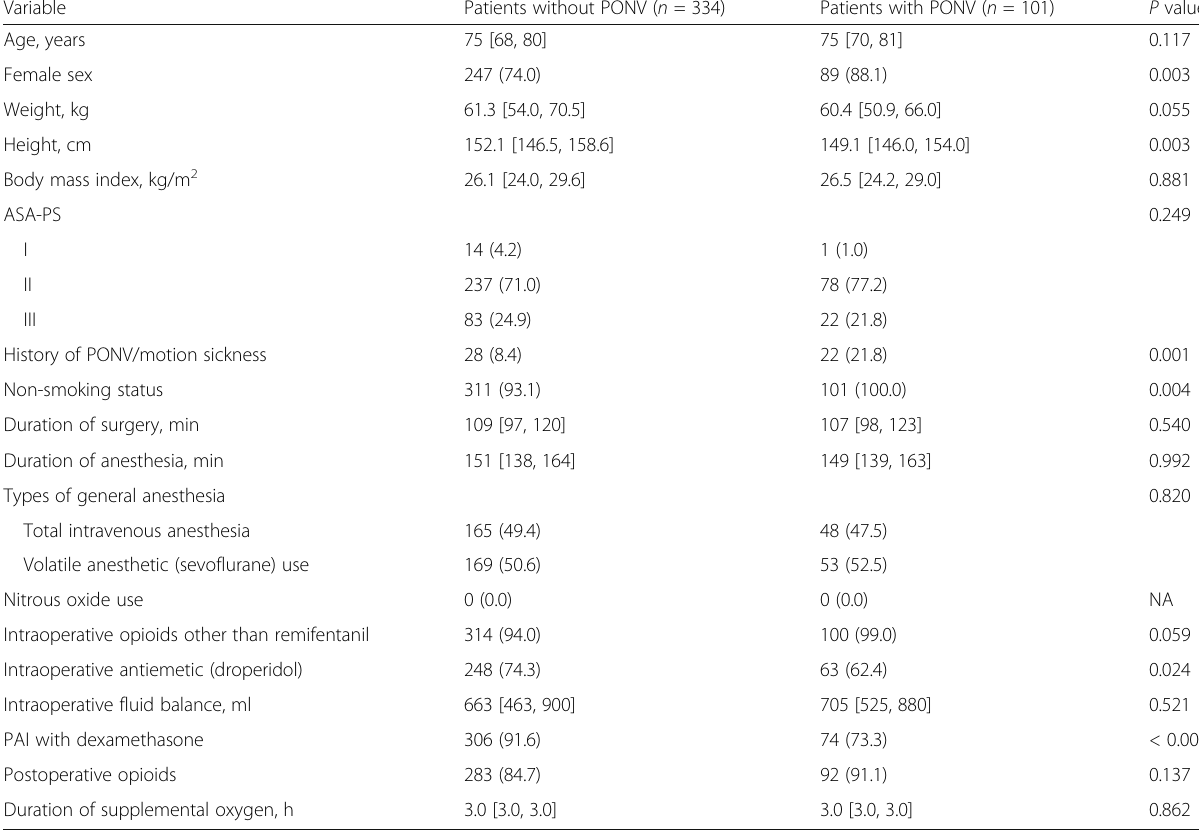
Table 1 Characteristics of patients with and without postoperative nausea and vomiting Variable Patients without PONV ( n = 334) Patients with PONV ( n =